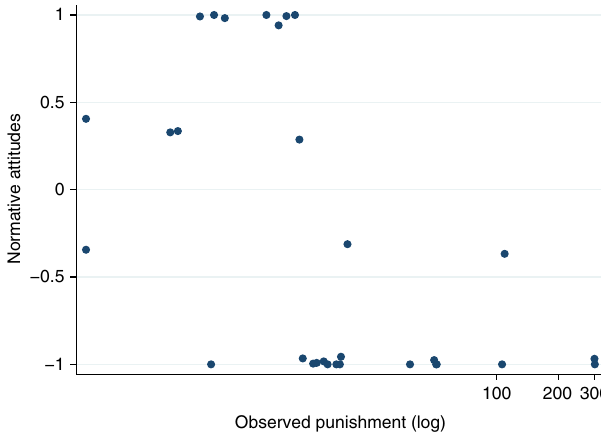
Fig. 5 Normative attitudes towards contributing zero and total punishment observed in the P20h treatment. Points have been jittered to distinguish overlapping observations. n = 30, Spearman ’ s ρ = – 0.665